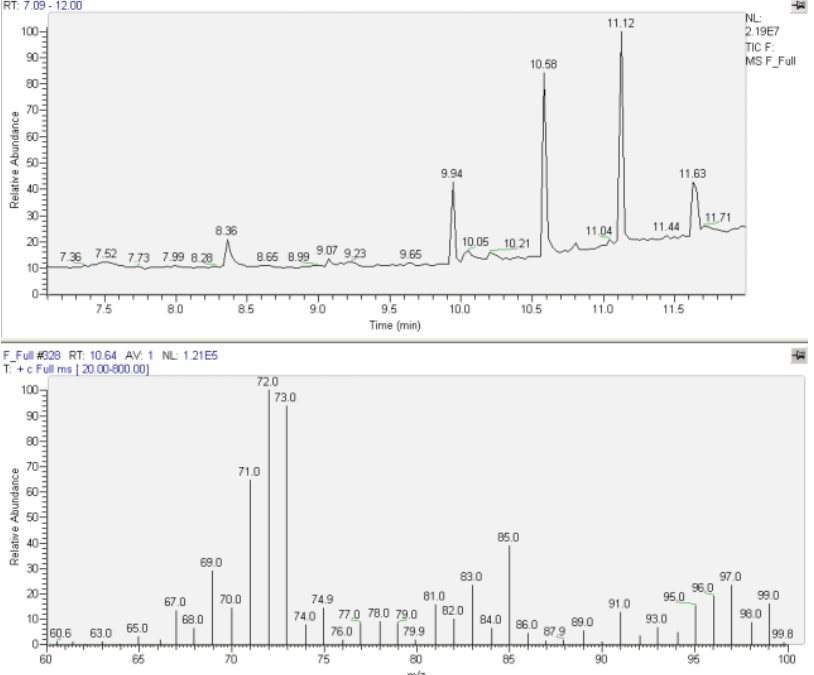
Figure 2. Typical chromatogram and MS spectrum for methadone identification in patients’ plasma sample—FULL (t R = 10.64, m/z = 72), Patient 14.